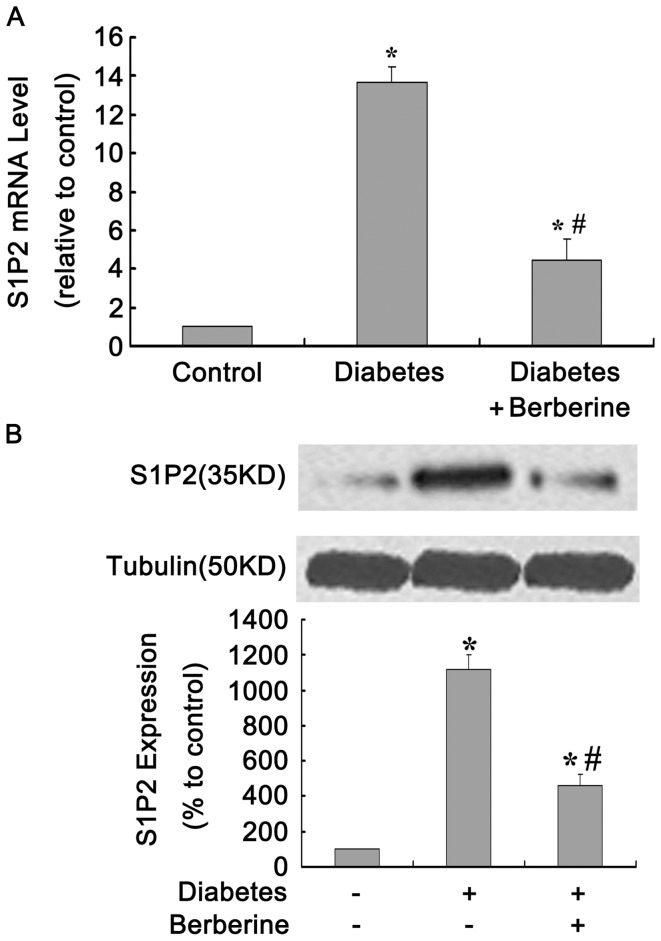
BBR reduced mRNA and protein expression of S1P2 receptor in diabetic rat kidneys.STZ-induced diabetic rats were treated for 12 weeks with BBR, and the levels of mRNA (A) and protein (B) of S1P2 receptor were evaluated by real-time PCR and Western blot, respectively. Data are represented as Means ± SDs, *P<0.05 vs. control, #P<0.05 vs. diabetes.